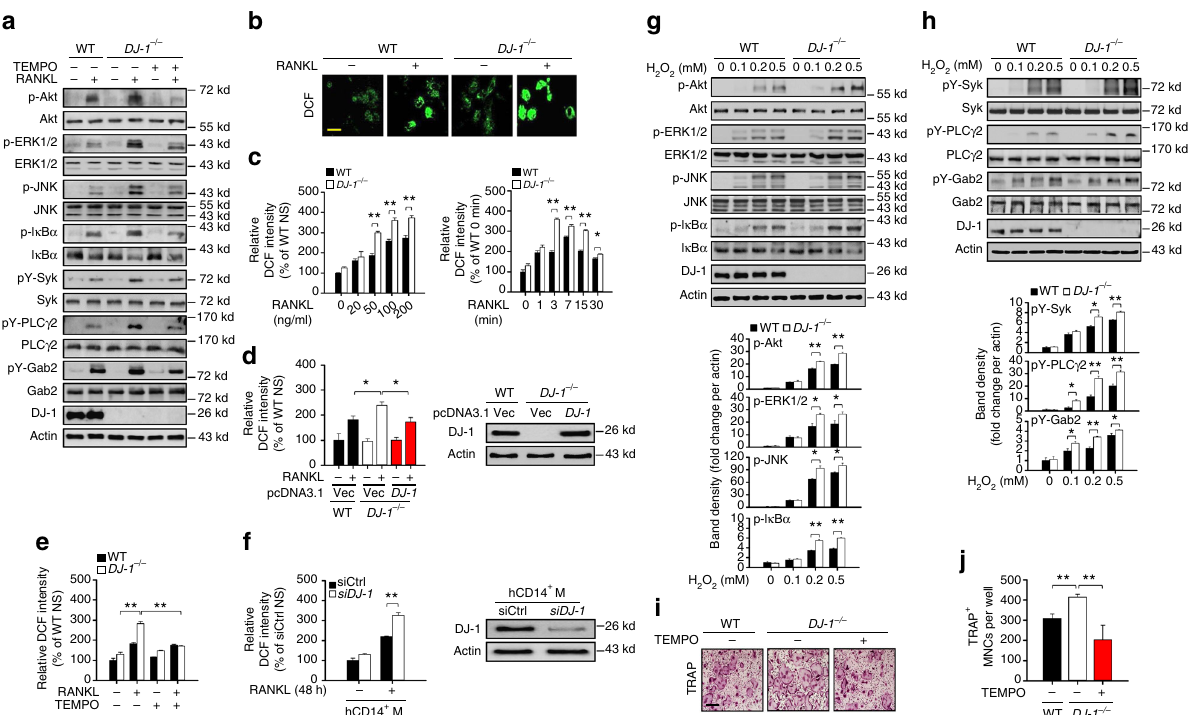
Fig. 4 DJ-1 controls the RANK signals via suppression of ROS. a Representative immunoblot images for phosphorylated forms of signaling proteins stimulated by RANKL with or without TEMPO (30 μ mol L − 1 ) in WT or DJ-1 − / − BMMs. b Representative images for DCF fl uorescence in WT or DJ-1 − / − BMMs stimulated with 100 ng ml − 1 RANKL for 10 min. Magni fi cation, ×400 and scale bar, 50 μ m. c Relative DCF intensity in BMMs under the indicated conditions. d Relative DCF intensity shown as the mean ± s.e.m. (left) and representative images (right) in WT or DJ-1 − / − BMMs with the transfection of DJ-1 plasmid or empty vector from three independent experiments in triplicate. ** p < 0.01 by one-way ANOVA with post hoc Tukey ’ s test. e Relative DCF intensity in WT or DJ-1 − / − BMMs incubated with or without 30 μ mol L − 1 TEMPO. f Relative DCF intensity in human CD14 + monocytes stimulated by RANKL for 48 h after the transfections of control siRNAs (siCtrl) or DJ-1 -targeted siRNAs (siDJ-1). g , h Representative immunoblot images (upper panel) and relative band densities (lower panel) for essential signaling proteins for OC differentiation in BMMs stimulated by H 2 O 2 for 15 min g or 5 min h . i Representative images (magni fi cation, ×100 and scale bar, 200 μ m) and j number of TRAP + OCs in RANKL-induced WT and DJ-1 − / − BMMs with or without TEMPO (30 μ mol L − 1 from three independent experiments in triplicate. ** p < 0.01 by one-way ANOVA with post hoc Tukey ’ s test. Representative images a , b , f – i or the mean ± s.e.m. c , e − h from three independent experiments in triplicate are shown. ** p < 0.01, * p < 0.05. by Student ’ s t